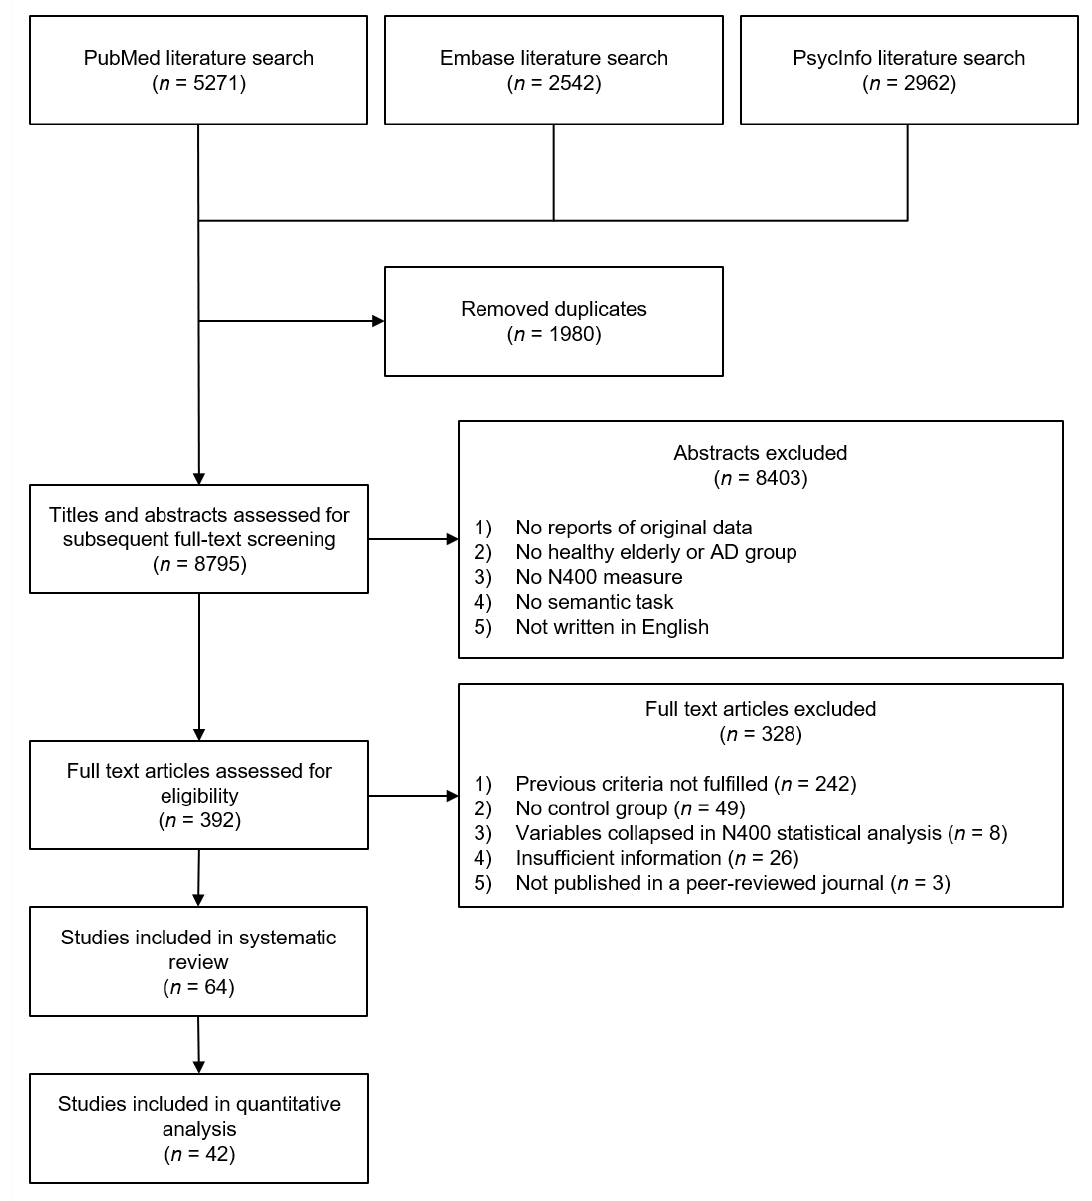
Figure 1. Schematic overview of the study selection procedure in this systematic review.